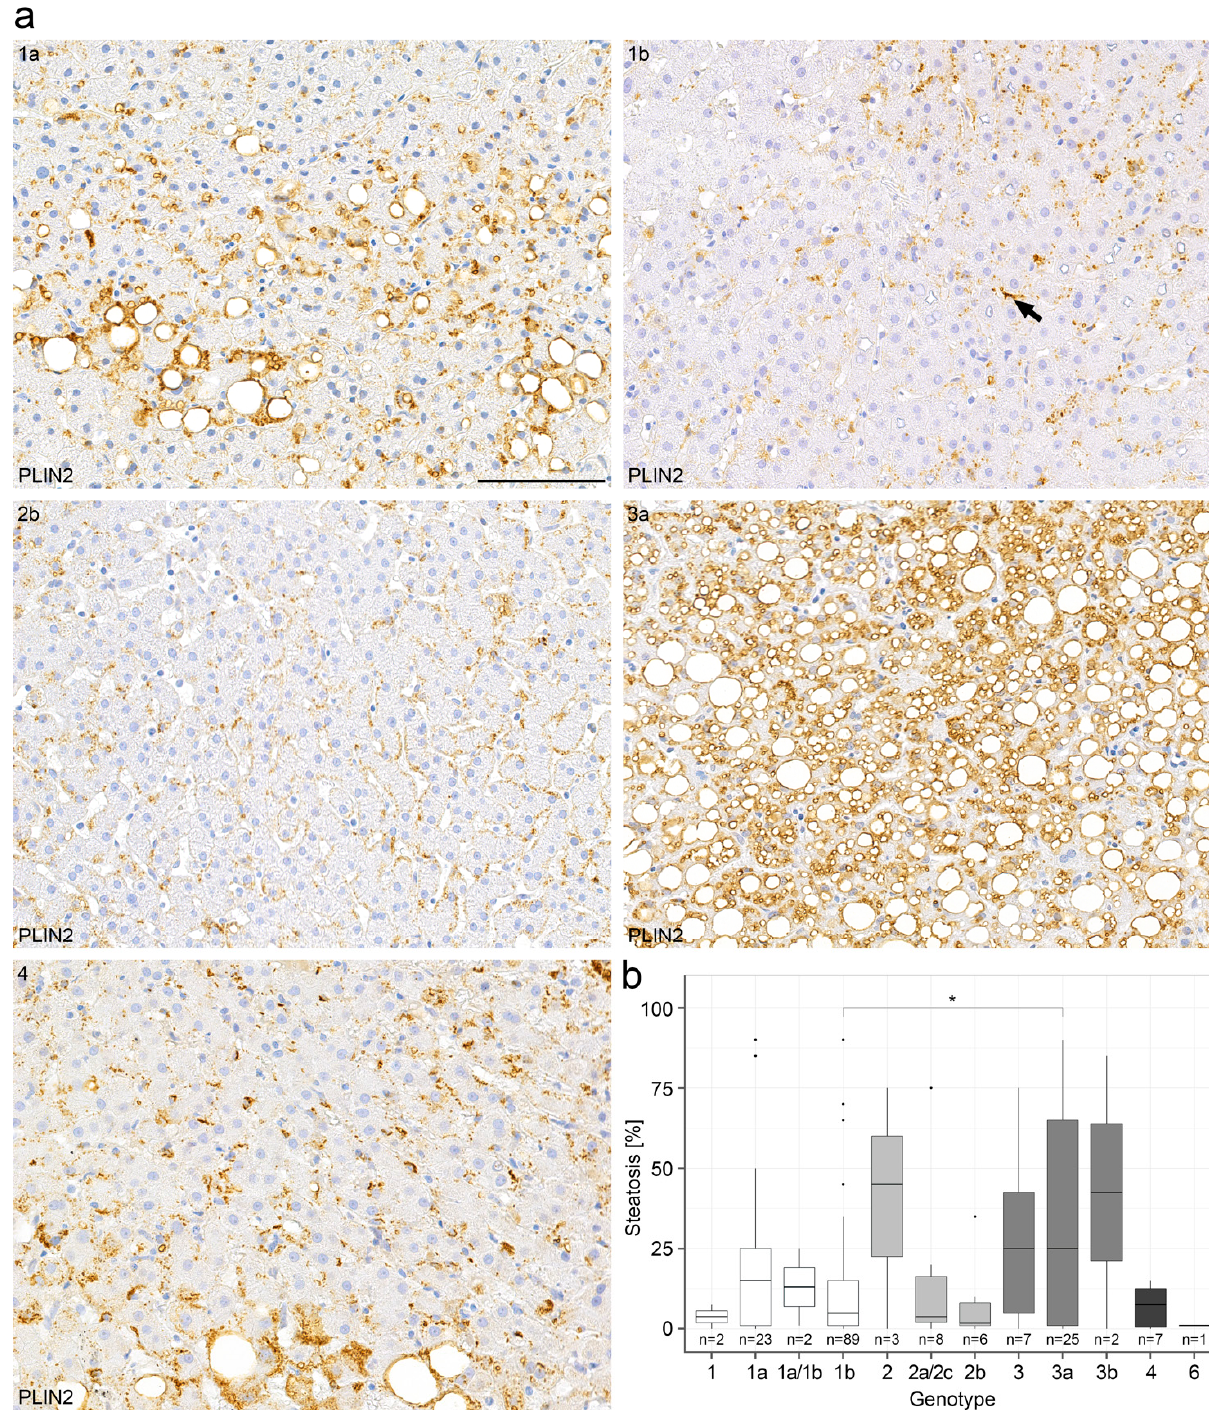
Figure 2. Perilipin 2 immunohistochemistry demonstrates different degrees of steatosis in chronic hepatitis C in relation to HCV genotype. ( a ) Representative immunohistochemical perilipin 2 (PLIN2) stains from a collection of 231 liver biopsies of patients with chronic hepatitis C with respect to the different HCV genotypes 1a,1b,2b,3a and 4. The arrow depicts perilipin-2 positivity in an HSC. ( b ) Correlation of the degree of steatosis as determined by conventional H&E stain with re- spect to the HCV genotypes (boxplot). Wilcoxon test with p = 0.014. p -values < 0.05 (*) were consid- ered significant. Scale bar = 100 µm. n = numbers of cases evaluated per genotype.